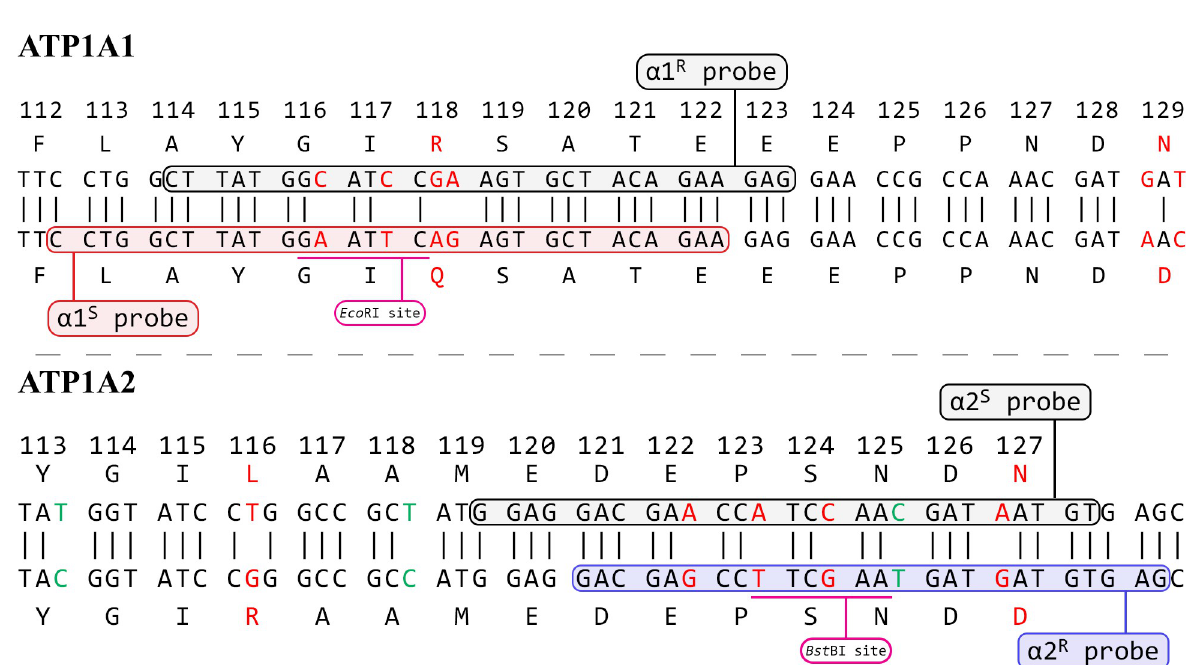
Fig 1. Sequence alignment of murine ATP1A and ATP1A2 variants and recognition sequences of the PCR probes. Amino acid numbering is based on current reference sequences for the murine NKA α 1 and α 2 subunits (from Table 1). ATP1A: gray highlight indicates the probe target site for the WT α 1 R mutant; red highlight indicates the probe target site for the sensitive α 1 S mutant. Base substitutions are indicated in red font. The presence or absence of vertical lines between sequences indicates whether a base change in the codon is conserved. ATP1A2: corresponding annotation. Blue highlight indicates the probe target site for the mutant α 2 R mutant. Green font indicates natural variance between C57BL/6J and 129S1/SImJ mouse strains.